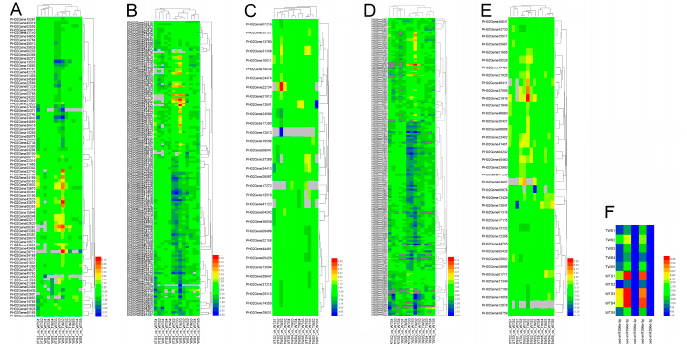
Figure 3. Expression patterns of five miR396s and their target genes that are differentially expressed in 13 combination pairs, including TWS5_vs_WTS5, TWS4_vs_WTS4, TWS3_vs_WTS3, TWS2_vs_WTS2, TWS1_vs_WTS1, TWS5_vs_TWS4, TWS4 _vs_TWS3, TWS3 _vs_TWS2, TWS2 _vs_TWS1, WTS5 _vs_WTS4, WTS4 _vs_WTS3, WTS3 _vs_WTS2, and WTS2 _vs_WTS1. ( A – E ) Tar- get genes of five miR396s. ( F ) Five miR396s. Gray squares represent miRNAs and their downregu- lated genes with TPM ≤ 1 or FPKM ≤ 1.